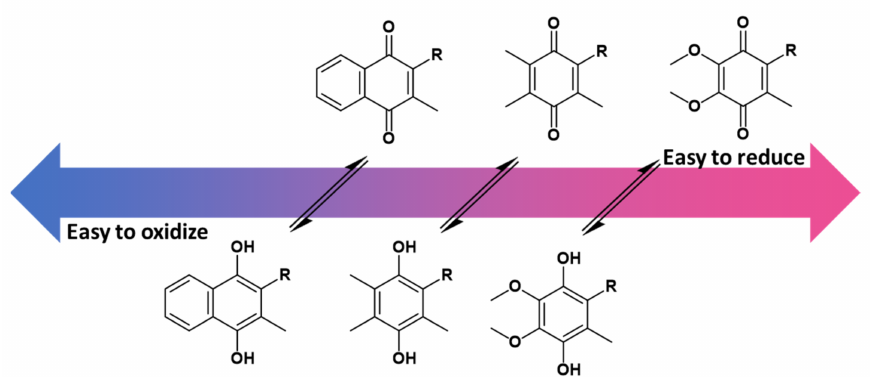
Figure 5. The redox potential of ubiquinone, plastoquinone, and menaquinone are shown relative to one another based on known reduction potential values [80]. Overall, menaquinones are the most difficult to reduce to the quinol form. Therefore, the menaquinol form is the easiest to oxidize back to the quinone. Ubiquinone is the easiest to reduce, and therefore ubiquinol is the most difficult to oxidize. Details of the extrapolations from the experimental data to the redox potential relevant to biological conditions are described elsewhere in detail. The conversion between quinone to quinol is represented with equilibrium arrows, but it is important to note that equilibrium is condition